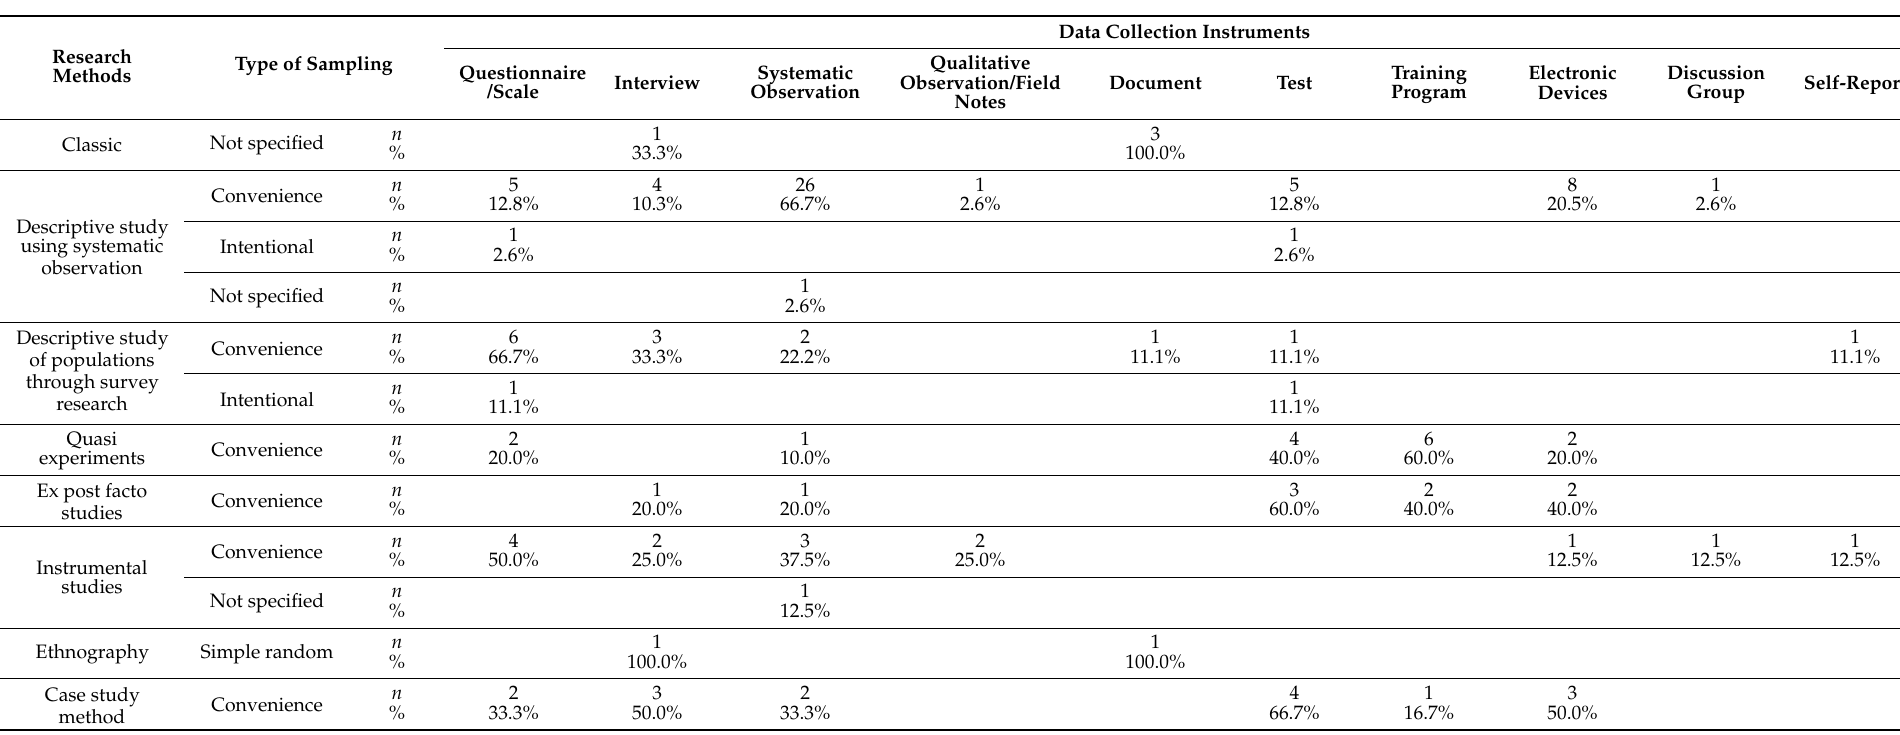
Table 1. Interaction of data between classification and research procedures relating the variables of search methods, data collection methods and type of